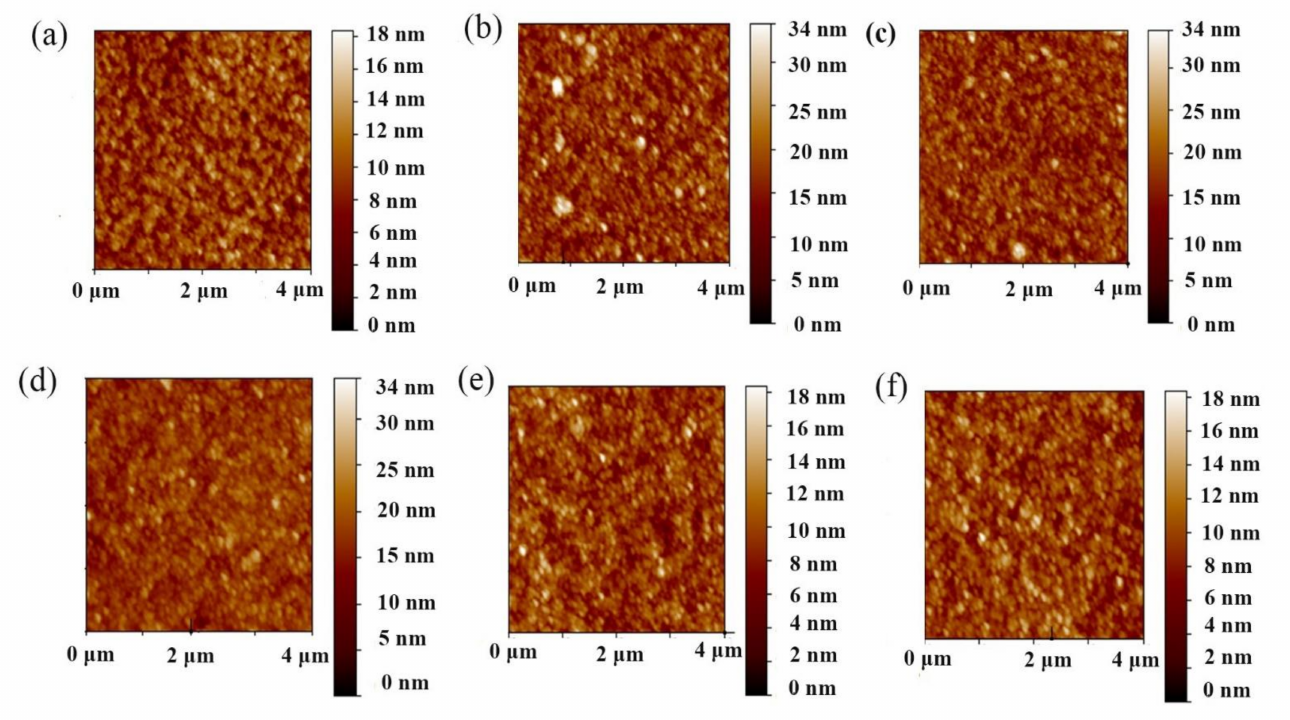
Figure 4. Atomic force microscopy (AFM) images of ITO/Mg-doped ZnO (MZO)/ZnO nanocrystals (NCs) (prepared by spin-casting ZnO NC solution onto the ITO/MZO substrate with different NC concentrations) with different thicknesses of ZnO NCs of ( a ) 0, ( b ) 10, ( c ) 15, ( d ) 20, ( e ) 30, and ( f ) 34